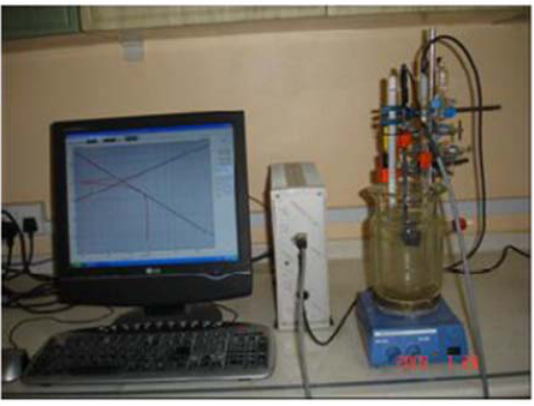
Fig. 1b. The Chemical Corrosion